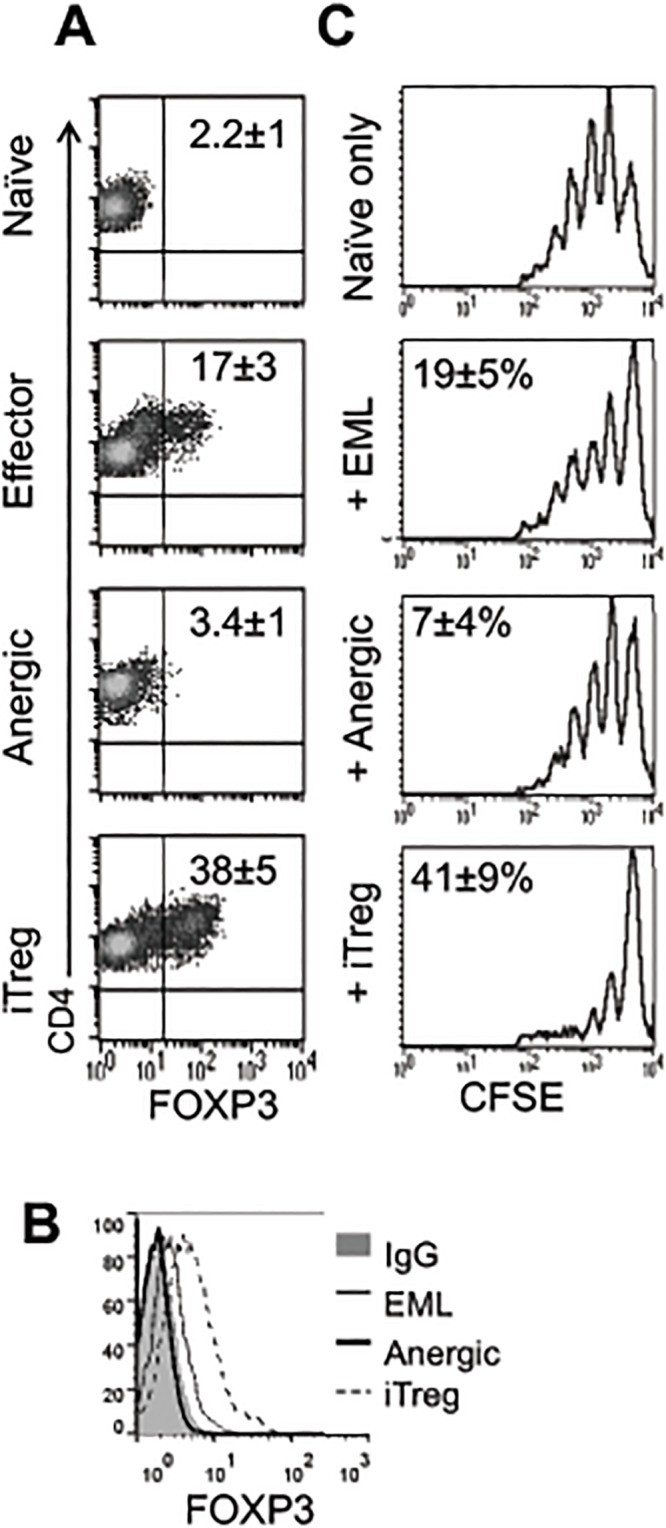
CD4+ T cells activated in the presence of CTLA4-Ig do not have properties of Treg cells.
A-C. Naïve cells were activated to generate effector or anergic cells as in Fig 1. For generation of regulatory T cells (Treg cells), αCD3, αCD28, TGF-β, and IL-2 were added for the first activation. A. The expression of FOXP3 in CD4+ T cells was measured on day 4 of activation or B. after an additional 3 days of rest in the medium. Numbers are percent of CD4+FOXP3+ cells ± SEM (n = 11) C. Each group of CD4+ T cells was purified 4 days after activation, rested for 3 days in medium, and co-activated with freshly purified CFSE-labeled allogeneic naïve CD4+ cells in the presence of αCD3 + αCD28–coated beads (0.1 μl of beads per 100 μl of medium) for 4 days. The proliferation rate of CFSE-labeled naïve cells was analyzed by FACS. Shown is the average ± SEM percent inhibition of naïve cell proliferation (n = 6). EML, effector/memory-like T cells; iTreg, induced regulatory T cells.